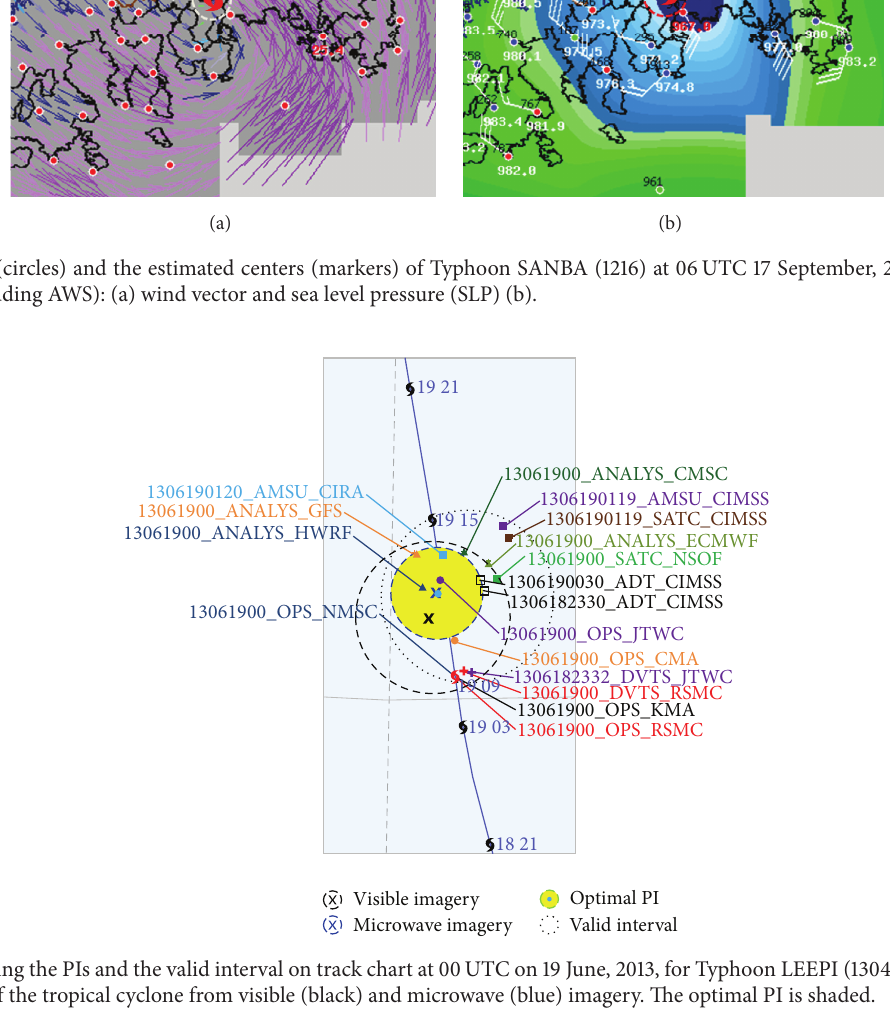
the radar images and synoptic observation data were excluded because estimation of the PI was